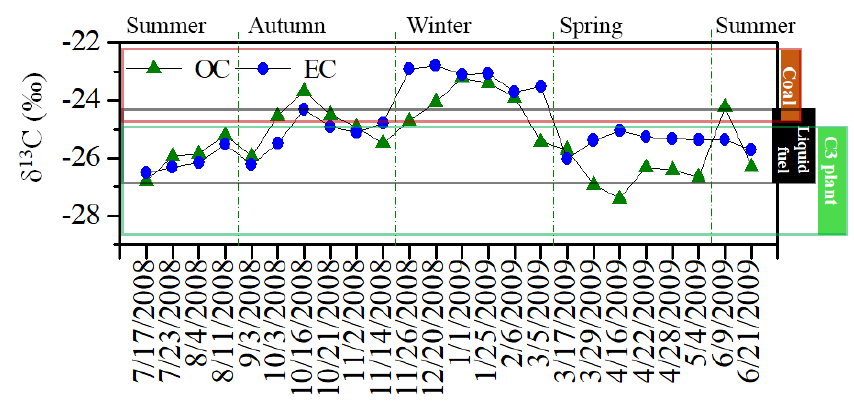
Figure 2. Stable carbon signatures ( δ 13 C) in OC and EC for the samples selected for 14 C measurements. The δ 13 C signatures of burning C 3 plants (green rectangle), liquid fossil fuel (e.g., oil, diesel, and gasoline, black rectangle), and coal (brown rectangle) are indicated as mean ± standard deviation in Table S1. The δ 13 C endmember ranges for C 4 plant burning ( − 16 . 4 ± 1 . 4‰; Table S1) are much more enriched than other sources, and are not shown in this